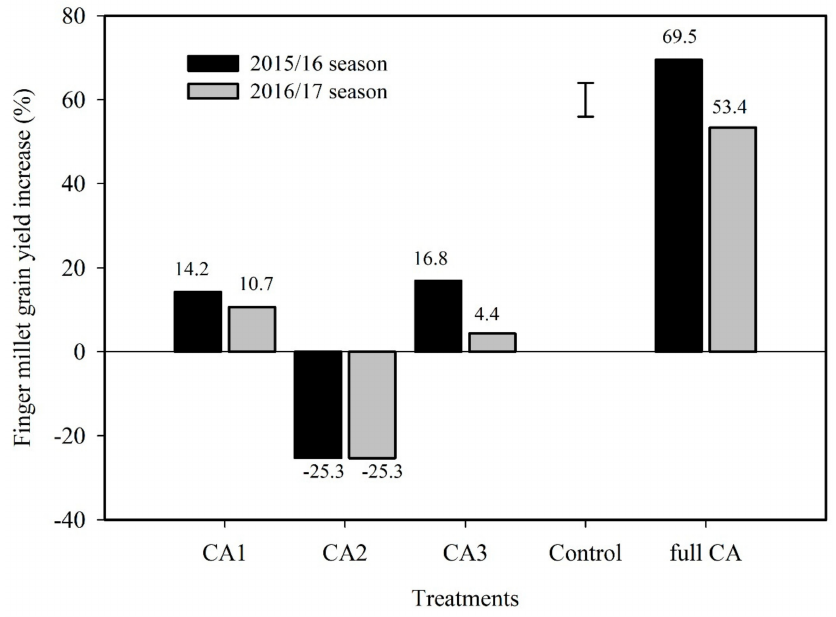
Figure 7. Finger grain yield increase with reference to conventional tillage only (control) with conventional tillage + mulch (partial CA1), reduced tillage only (partial CA2), reduced tillage + mulch (partial CA3) and reduced tillage + mulch + intercropping with cowpea (full CA) treatments during 2015/16 and 2016/17 cropping seasons. Error bar represents LSD 0.05